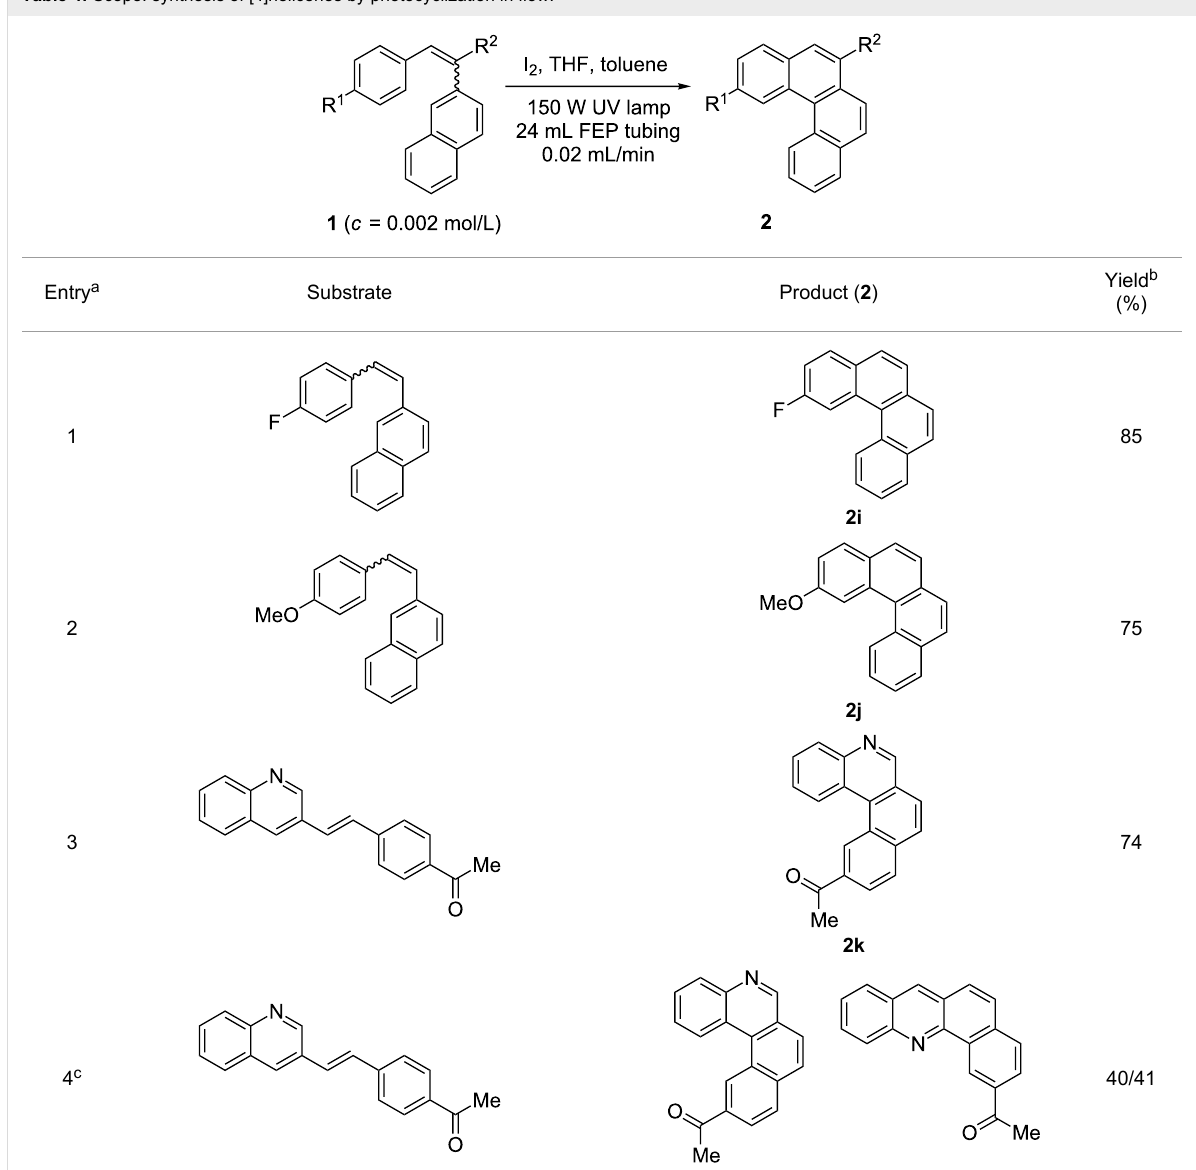
Table 4: Scope: synthesis of [4]helicenes by photocyclization in